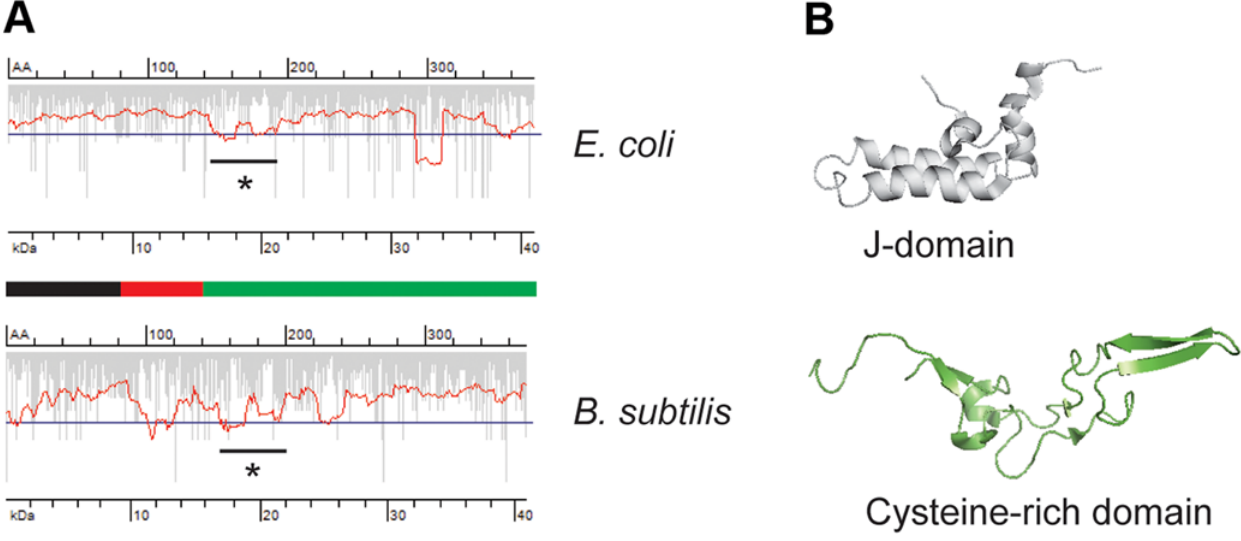
Figure 6. Proteins with conserved physiological functions have similar translation attenuation pattern. (A) The ORF of DnaJ from E. coli and B. subtilis revealed a translational mimimum located downstream of the glycine-rich flexible linker (red part of the schematic primary structure below the smoothed translation profile plots) joining the N-terminal J-domain (black) and C-terminal cysteine-rich domain (green). The overlapping attenuation site in both ORFs is marked with a star. For details of the description of the translation profile plots see the legend to Fig. 1. (B) Structures of E. coli J-domain (pdb-code: 1BQZ) and cysteine-rich domain (pdb-code: 1EXK) resolved by NMR.